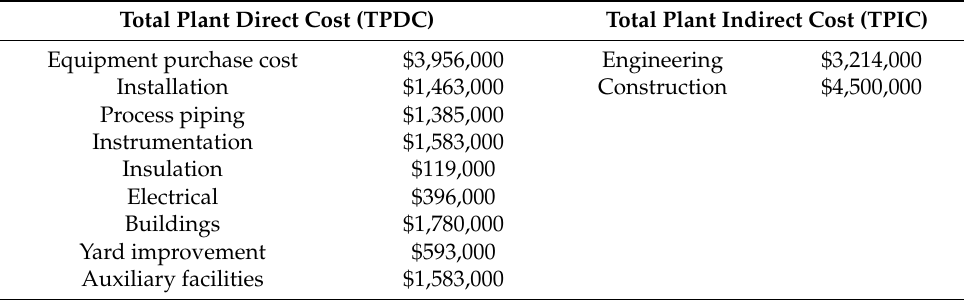
Table 9. Total plant direct and indirect costs.